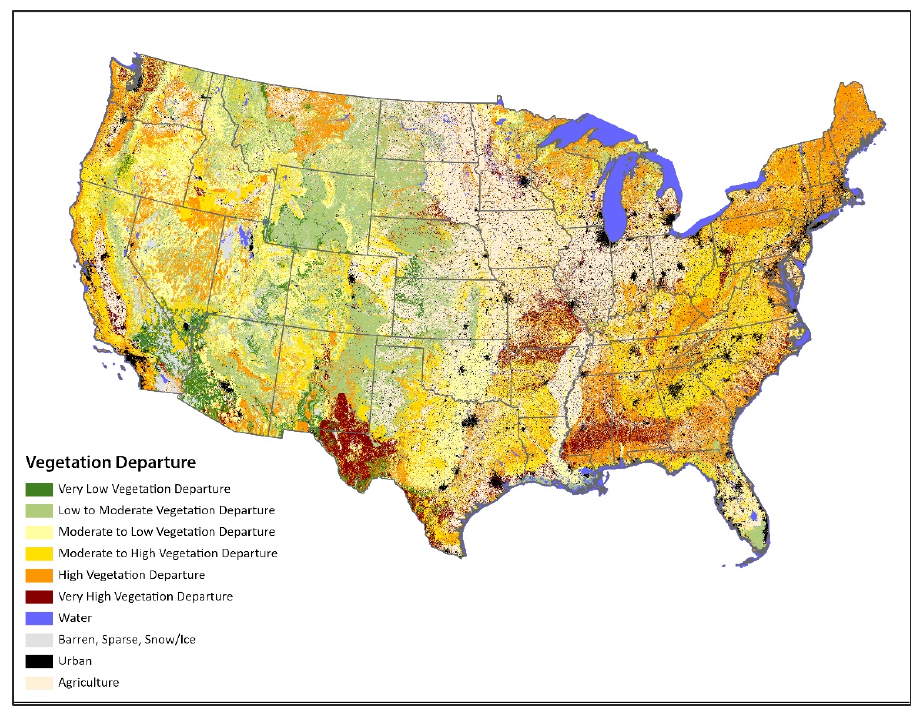
Figure 1. The LANDFIRE Vegetation Departure spatial layer [54] depicts the difference between a pre ‐ European colonization reference condition and current conditions.